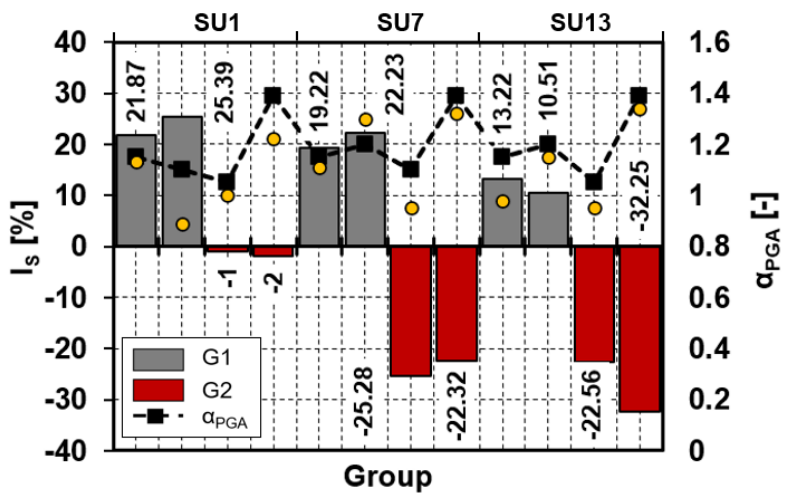
Figure 12. Sensitivity analysis for the clustered configurations examined.